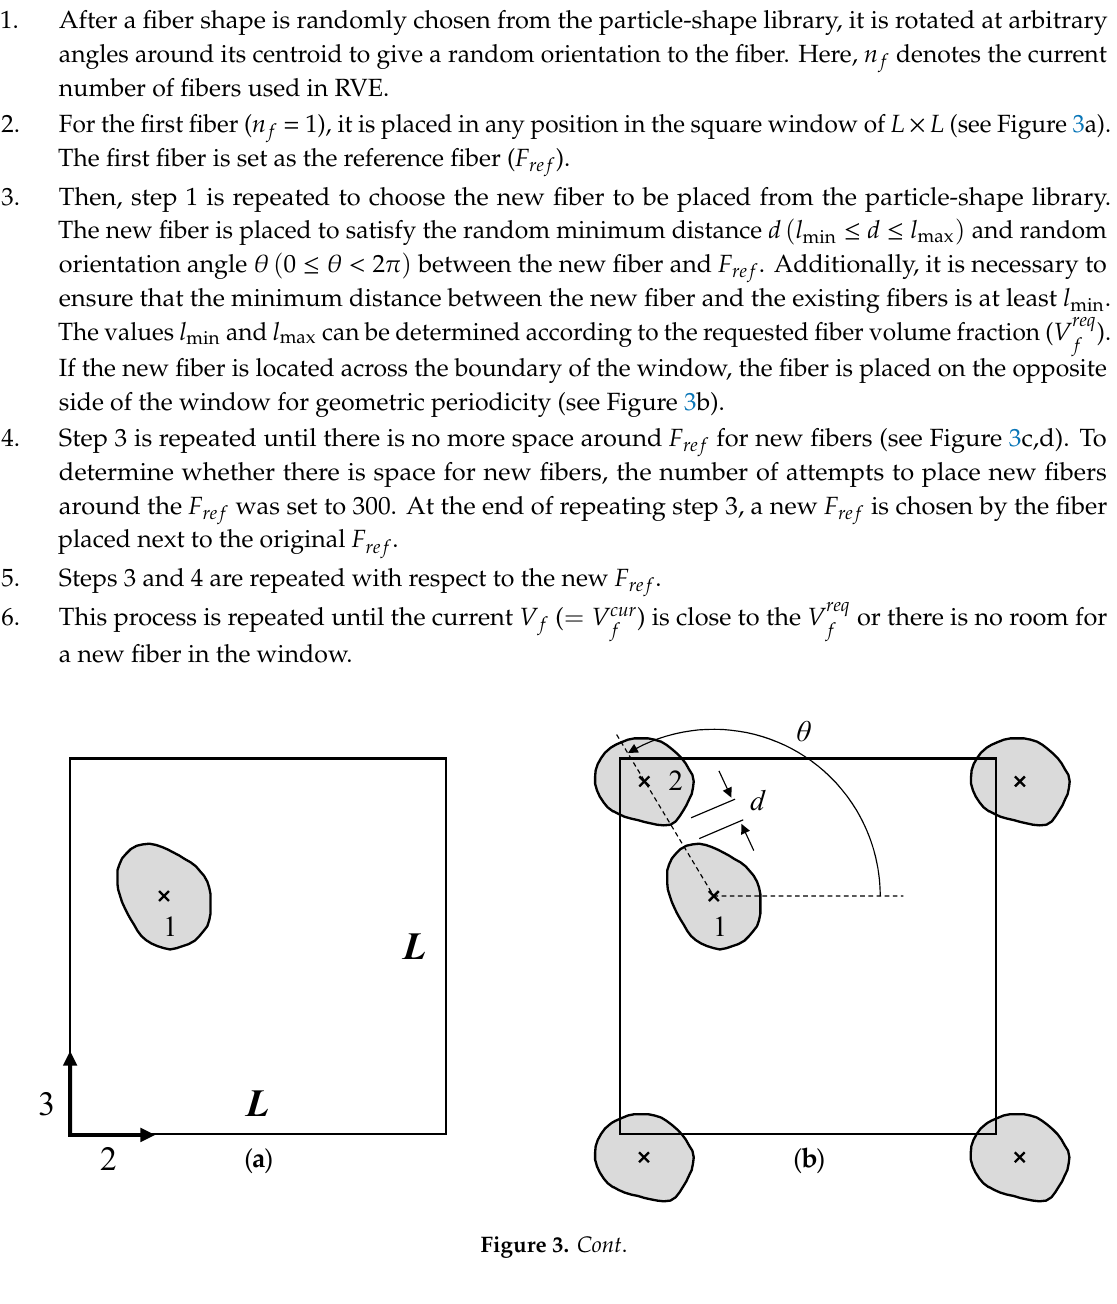
Figure 3. Schematic illustration of the RSE algorithm with actual fibers: ( a ) step 2, ( b ) step 3, and ( c , d ) step